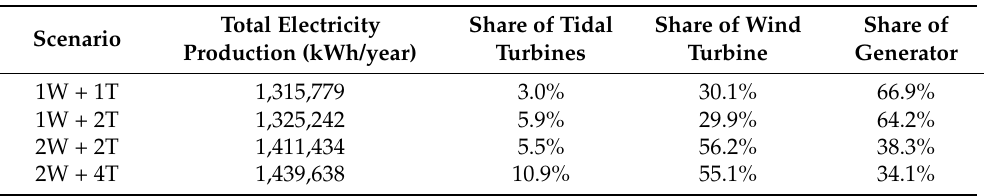
Figure 15. Monthly average output power for ( a ) 1W + 1T, ( b ) 1W + 2T, ( c ) 2W + 2T, ( d ) 2W + 4T. Table 6. Share of wind and tidal turbines in electricity production. Table 6. Share of wind and tidal turbines in electricity production.